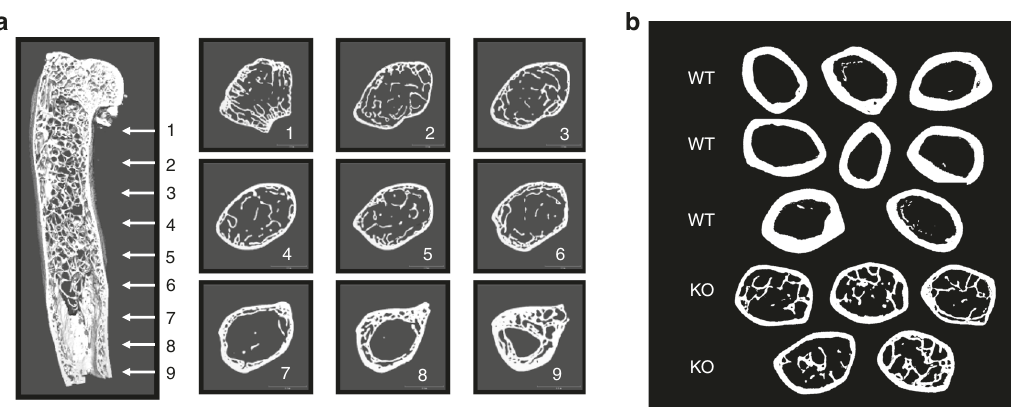
Fig. 2 Femur microCT images obtained from a male mouse at 105 weeks of age. a Longitudinal image from one Sfrp4 KO femur. b Midshaft cross-section images of 8 WT and 5 KO